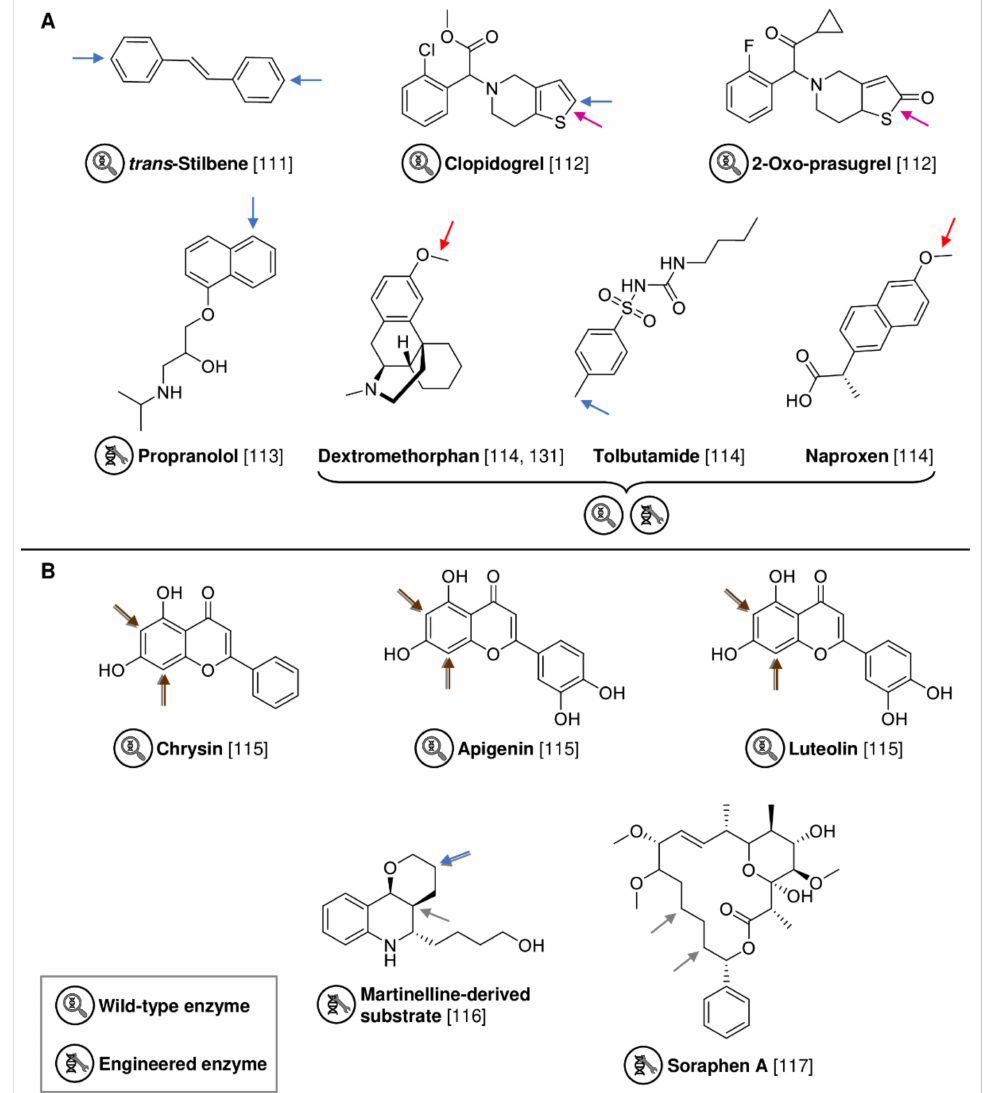
Figure 12. Functionalization of mentioned substrates by wild-type or engineered UPOs ( A ) and halo- genases ( B ). Functionalization sites are highlighted with a colored arrow representing hydroxylation (blue), demethylation (red), dealkylation (green), C-S bond cleavage (pink), chlorination (grey) or bromination